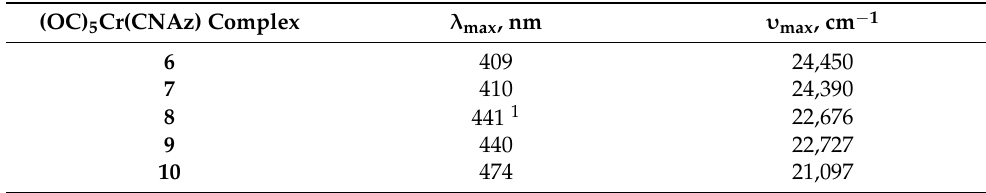
Table 3. Properties of the MLCT (L = CNAz) bands observed in the electronic absorption spectra of 6 , 7 , 8 , 9 , and 10 in CH 2 Cl 2 at 24 ◦ C.